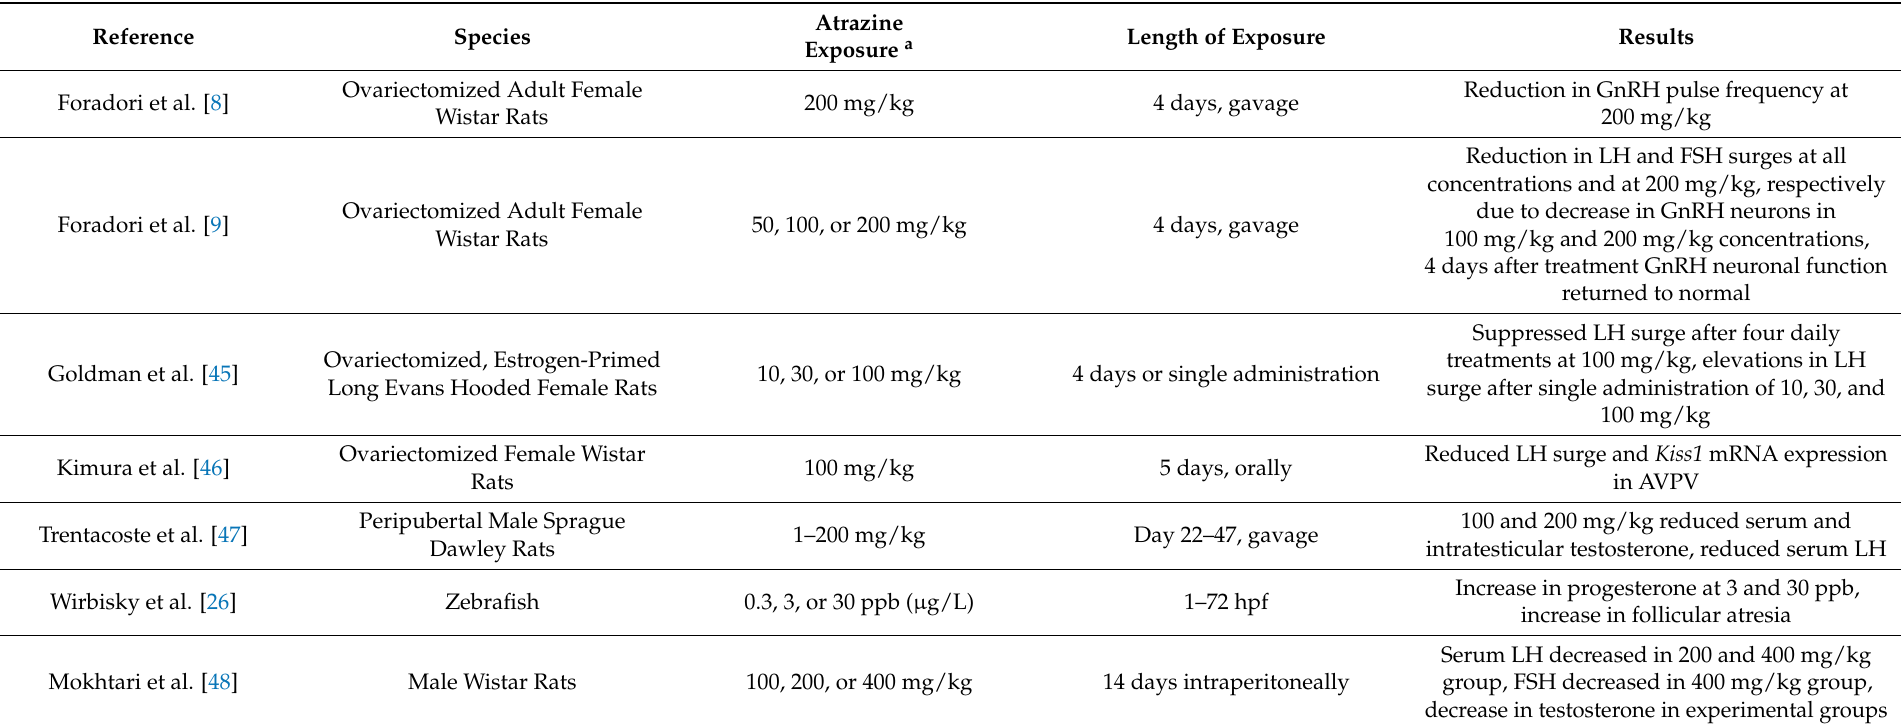
Table 1. Atrazine adverse impacts reported along the HPG